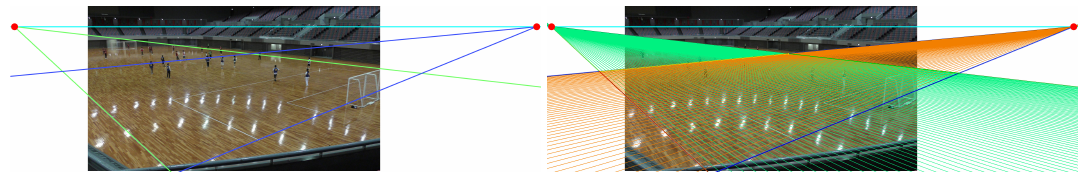
Figure 3. The soccer field in the captured image can be equally divided by lines drawn from two vanishing points. The vanishing points were obtained by first considering the field is rectangular in shape. By combining this vanishing point with the perspective technique, it was possible to divide the field into an arbitrary number of divisions. However, it was not strict.